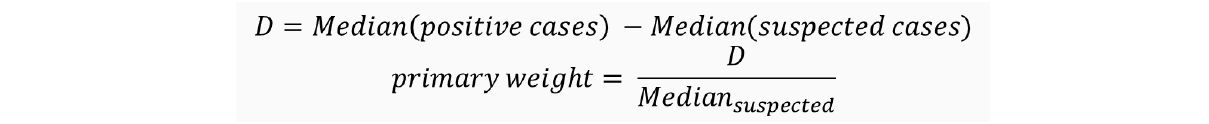
Figure 5. Primary weight